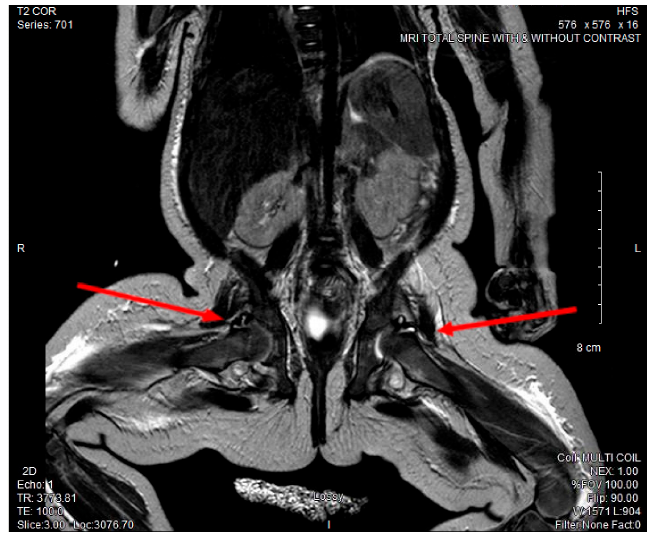
Figure 2. MRI full spine and hips with and without contrast. Abnormal T2 signal enhancement of bilateral hip joints. Table 1. Hematologic and rheumatologic diagnostic tests, patient results, and reference ranges (dL, deciliter; INR, international normalized ratio; IU, international unit; µ g/, microgram; mg, milligram; ng, nanogram; PAI, plasminogen activator inhibitor; PTT, partial thromboplastin